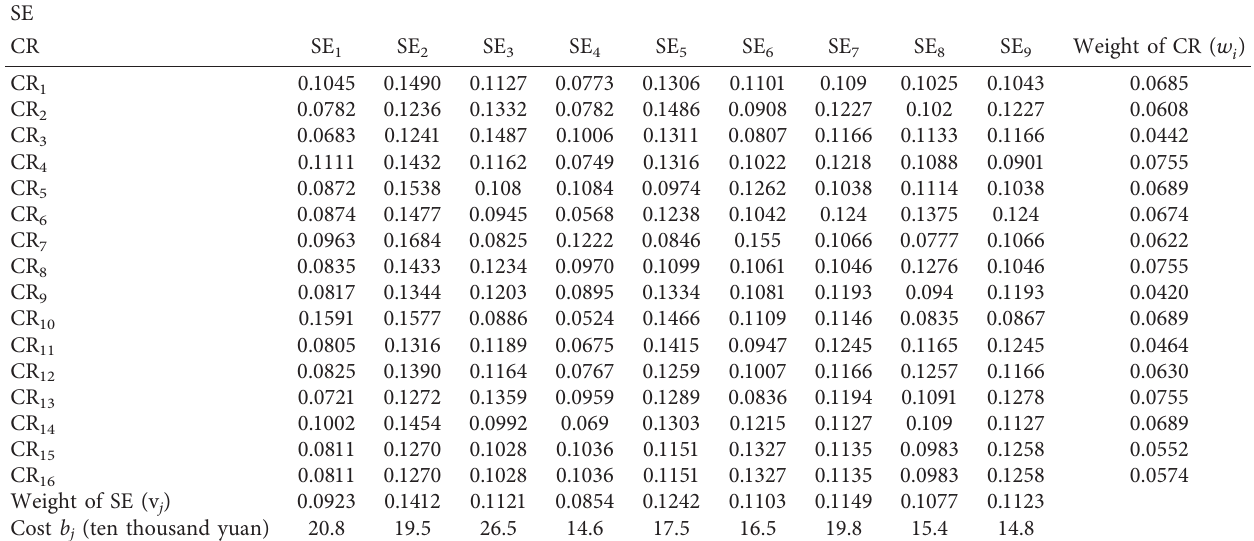
Table 8: House of quality of express